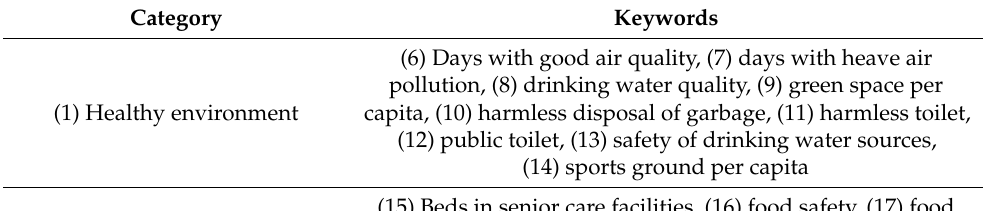
Table 1. The list of keywords used for retrieving the internet search queries.